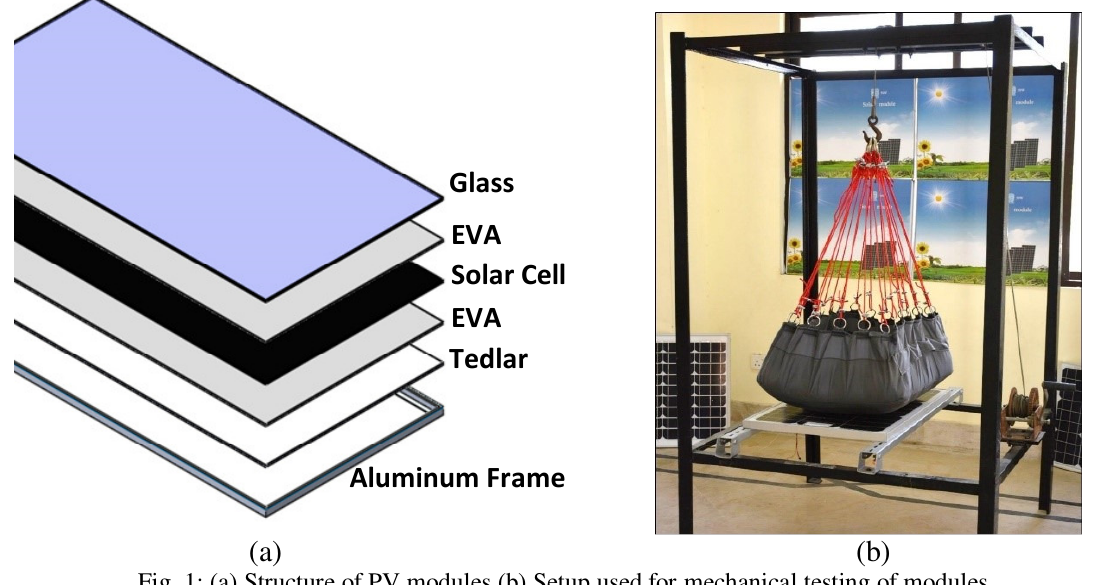
Fig. 1: (a) Structure of PV modules (b) Setup used for mechanical testing of